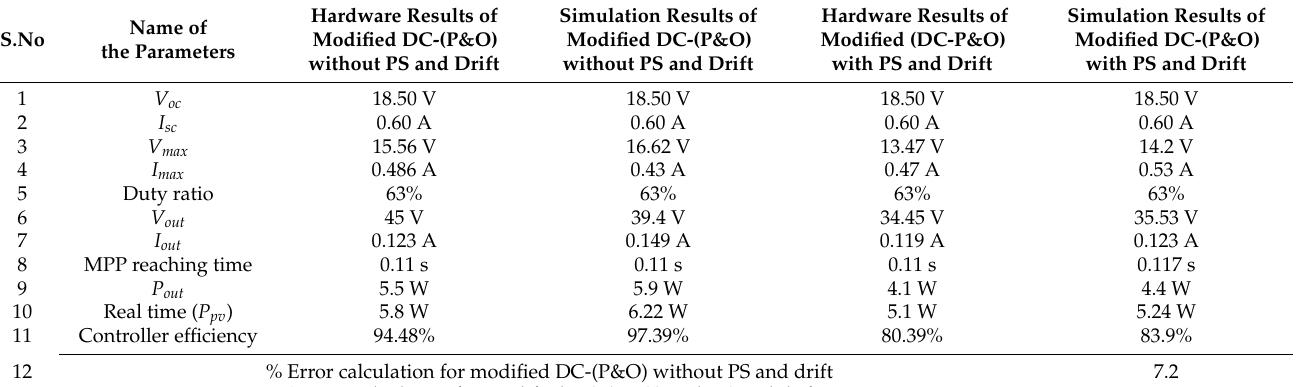
Table 4. Experimental validation and comparison of hardware and simulation results at 270 W/m 2 .